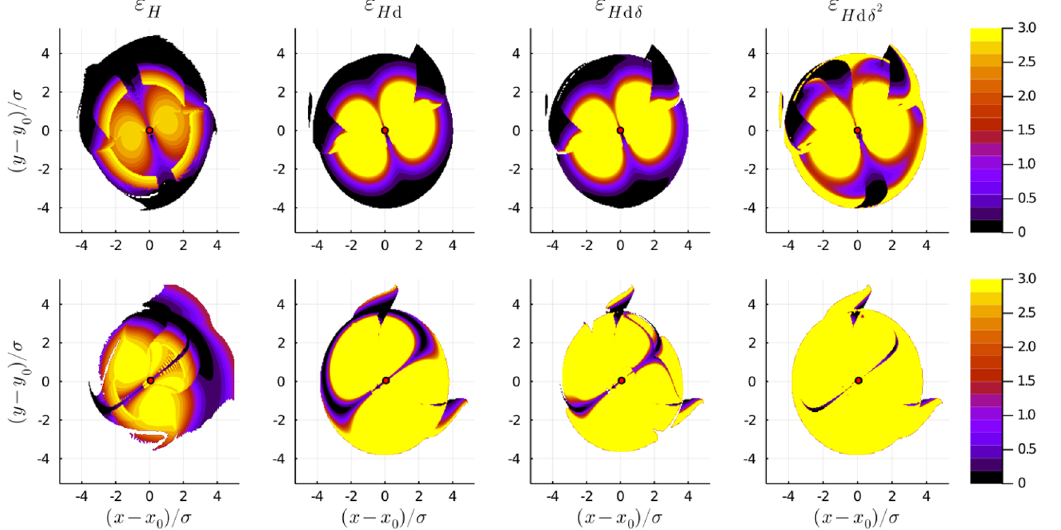
Figure 2 . We show the implied (cid:15) from the solution with the smallest | ξ | , for parameter sets 1 and 2 in the upper and lower rows respectively. The first column displays the numerical method calculation, and the remaining columns show increasingly higher order results from the diagonal Hessian approximation. While the diagonal method begins converging for parameter set 1, in parameter set 2 regions with a large λ diverge (compare with the rightmost column of u /λ k